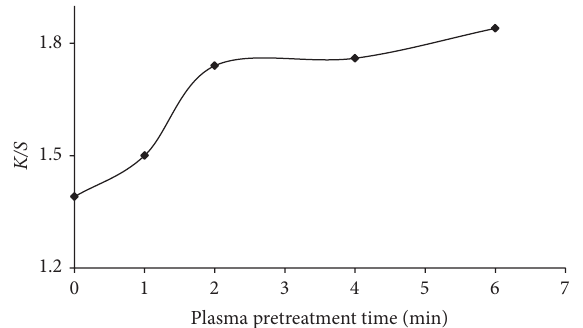
Figure 5: The effect of plasma pretreatment time on the color strength of dyed wool fiber with Prangos ferulacea.